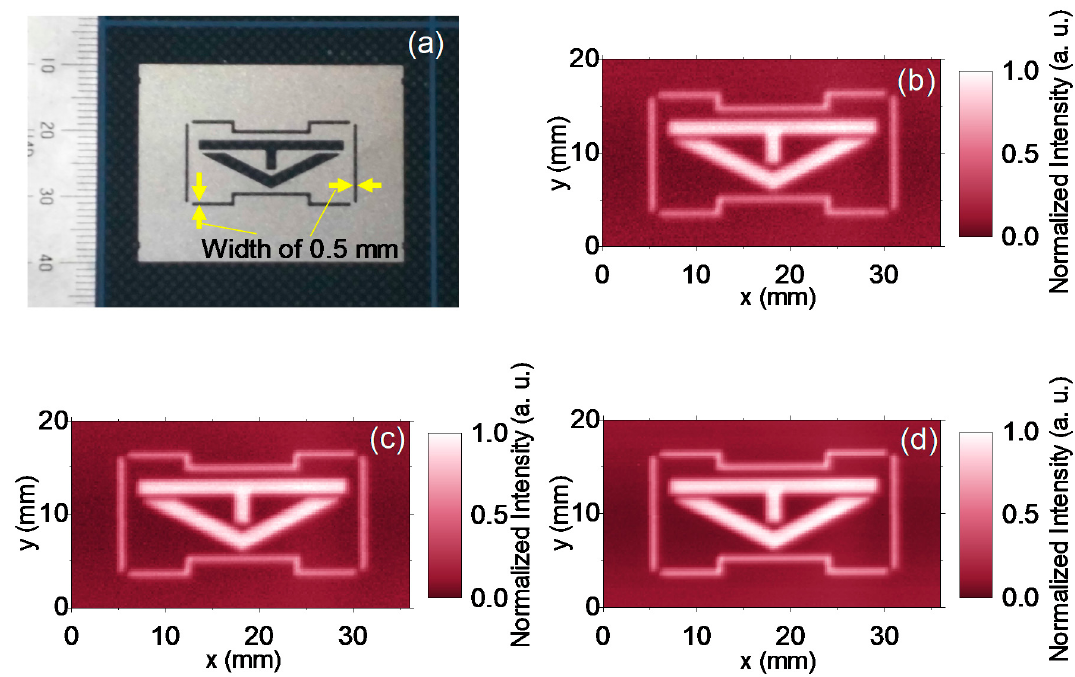
Figure 5. ( a ) Photograph of test object whose thickness was 0.3 mm. THz images of the test object obtained by THz NL-QCL at ( b ) 240K, ( c ) 200 K and ( d ) 160 K.